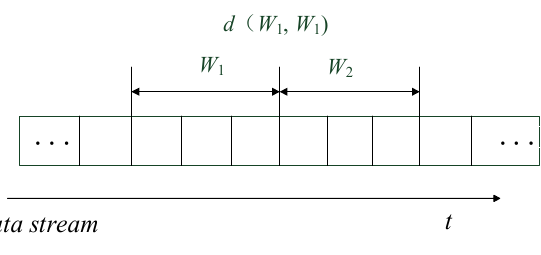
Figure 2. Two-window change detection model.